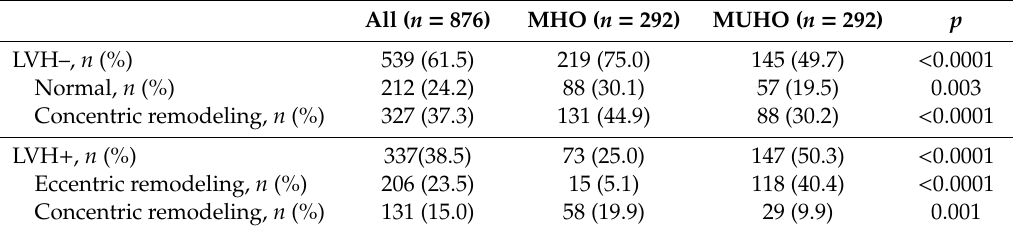
Table 3. Patterns of left ventricular geometry in the whole study population and according to di ff erent obesity phenotypes.